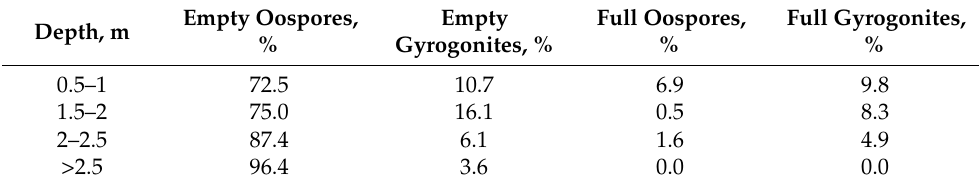
Table 1. The oospore bank structure in different depths.